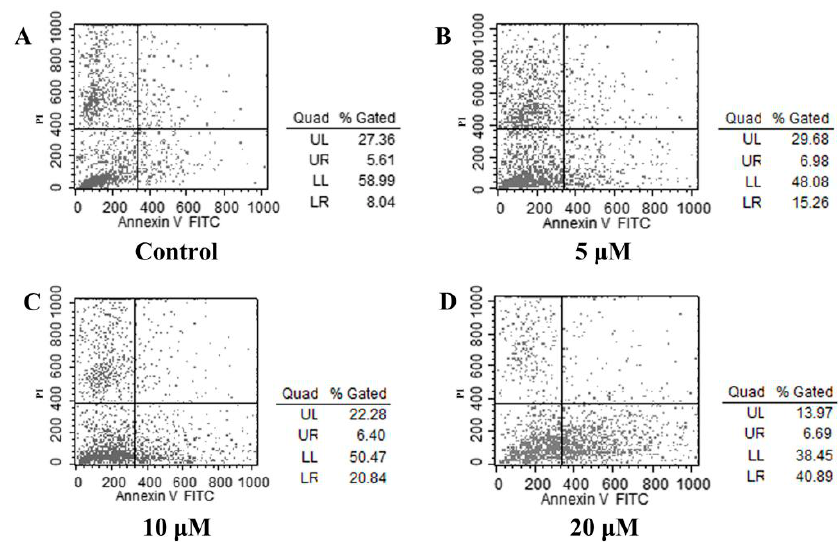
Figure 3. Apoptosis induction in HepG-2 cancer cell after treatment of compound 2n (5.0 µ M ( B ), 10.0 µ M ( C ), 20.0 Mm ( D ), and no treatment (Ctrl) ( A ) as a reference control for 48 h).